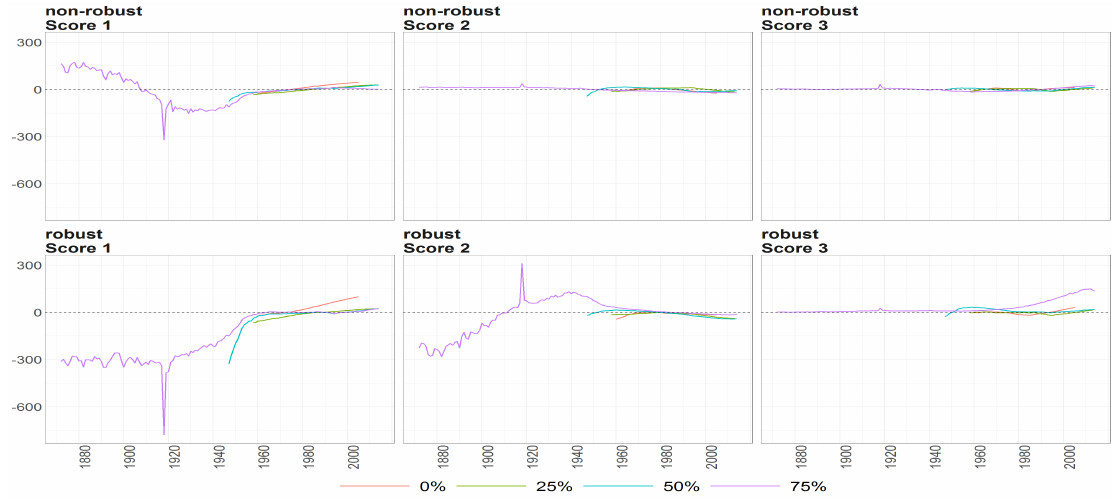
Figure 21. The scores (y axis) over time (x axis) obtained using PPCA for female population of Number of Deaths. Colours of lines correspond to the scores calculated on subsample where are different levels of maximum missing values per observation (0%, 25%, 50% and 75%, refer to legend). The plots placed in the first row correspond to the results using non- robust standardization of entry data, where the second row correspond to robust standardisation. The plots of scores are ordered by columns.